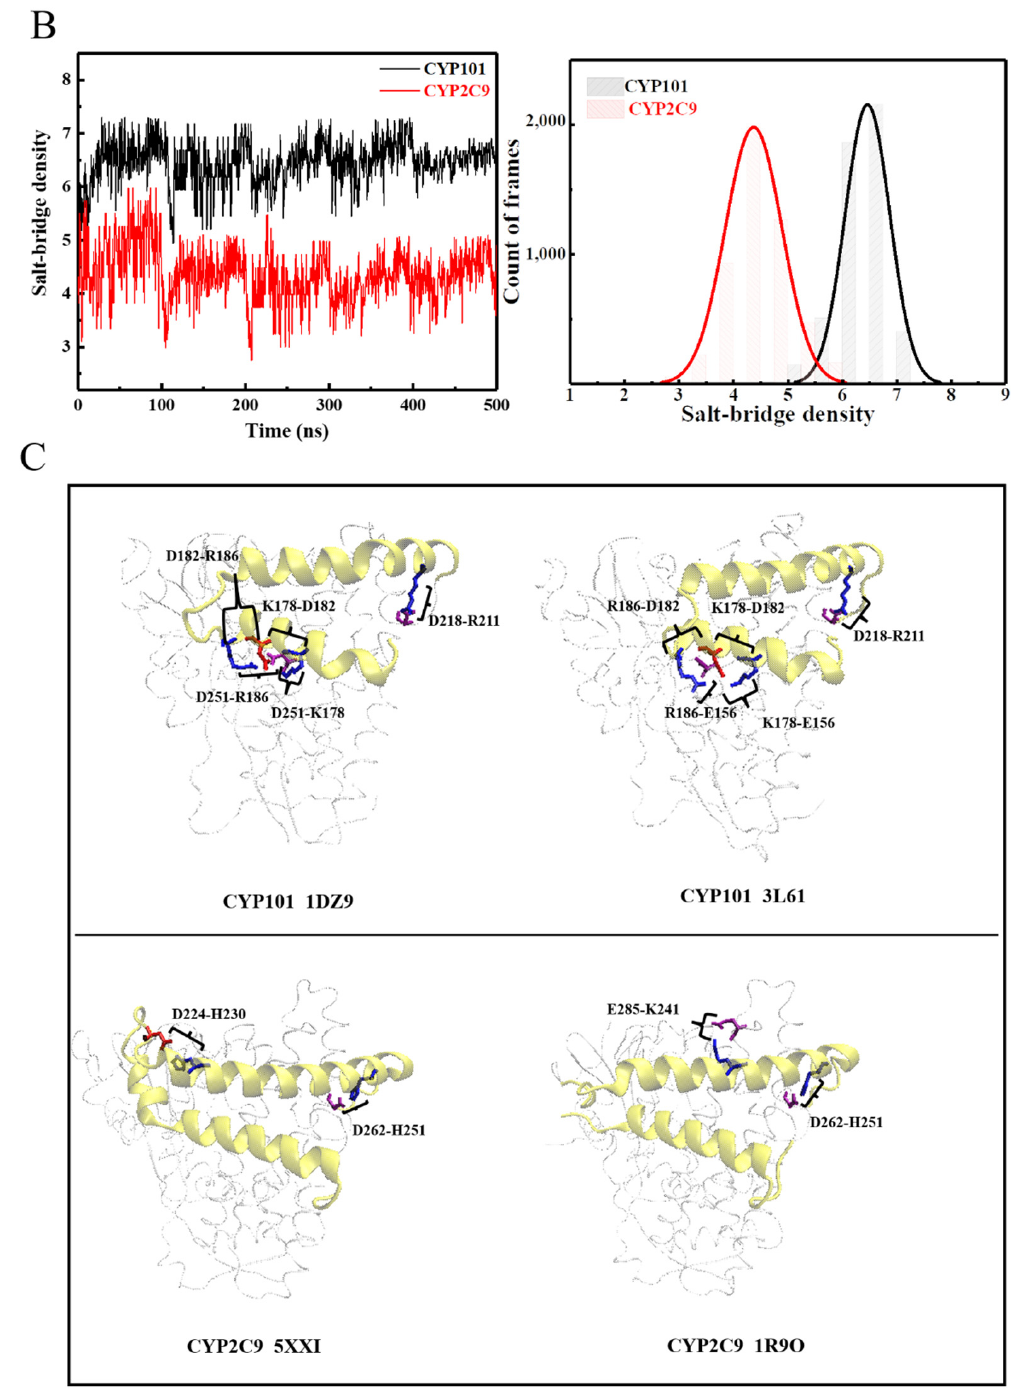
Figure 4. Comparison of salt bridges in CYP101 and CYP2C9. ( A ) The salt bridges with life time more than 20% of the simulation time in the protein structures of CYP101 (PDB: 1DZ9) and CYP2C9 (PDB: 5XXI), with the negatively and positively charged residues colored in red and blue, respectively. ( B ) The fluctuation of the salt-bridge densities over time observed in MD for CYP101 and CYP2C9, and the resulting distribution. ( C ) The salt bridges in the F–G region (yellow) of the crystal structures of CYP101 (PDB: 1DZ9 and 3L61, top) and those in CYP2C9 (PDB: 5XXI and 1R9O, bottom). We note that further analysis of more crystal structures confirmed that the conclusion that CYP101 has more salt bridges around the F–G region is generally valid. The results are not shown